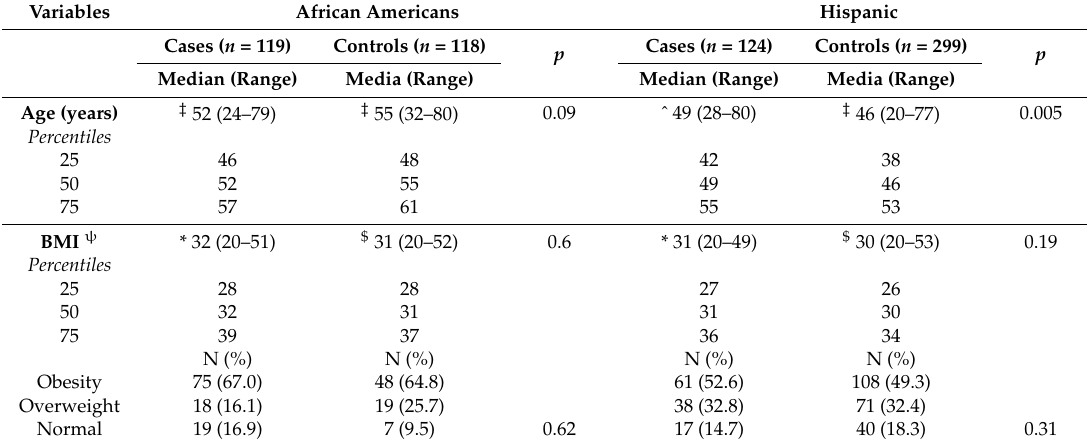
Table 1. Characteristics of Study population.